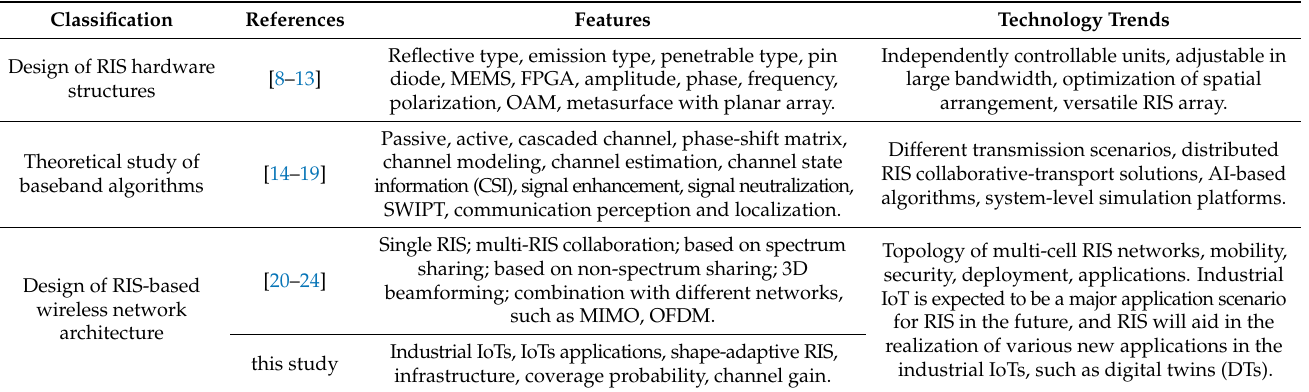
Table 1. Comparison of different RIS